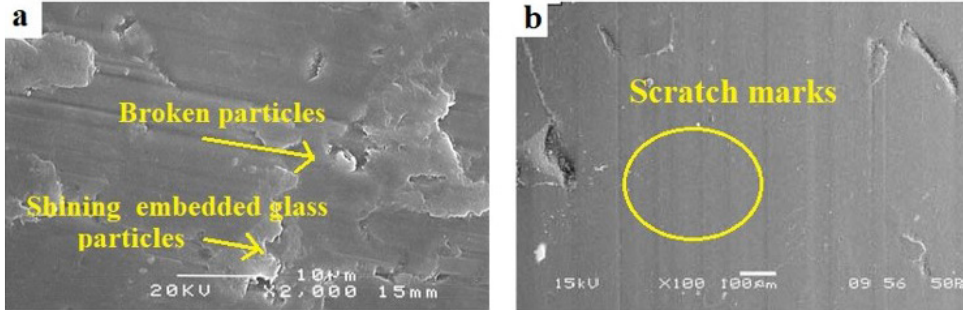
Figure 10. Morphological Structure of long fiber reinforced epoxy at 29.43N.